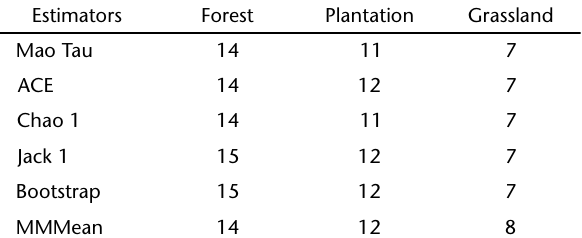
Table II. Results of different species richness estimators for the number of mammal species in the study area. (Mao Tau) Observed species richness, (ACE) Abundance-base Coverage Estimator, (Chao 1; Jack1) First-order Jackniffe richness estimator, (Bootstrap; MMMeans) Michaelis-Menten richness